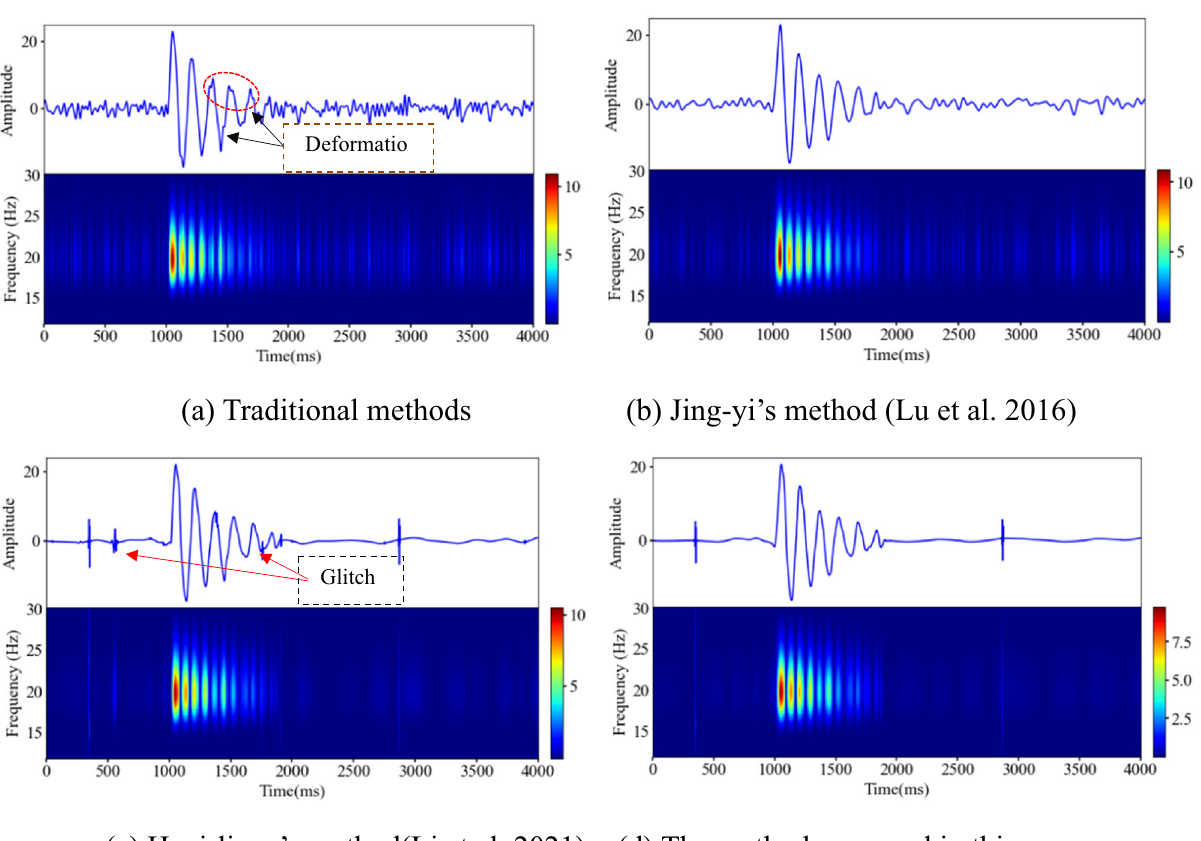
Figure 15. Denoising effect of the polluted signal of the microseismic simulation signal (Spyder(Python3.6)). ( a ) Traditional method ( b ) Jing-yi’s method 24 ( c ) Huai-liang’s method 9 ( d ) The method proposed in this paper.